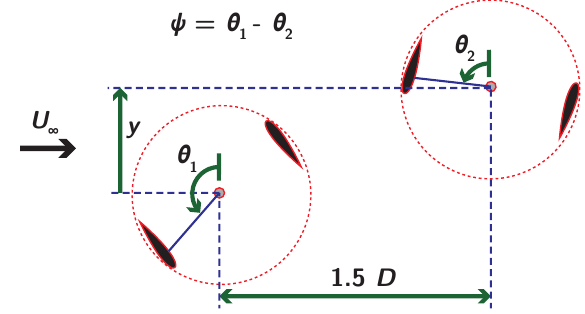
Fig. 3. Diagram of the coordinated control experiment. The blade position difference between turbines, ψ , is defined as the position of a blade in the upstream turbine minus the position of a blade in the downstream turbine. Under coordinated control operation ψ is held